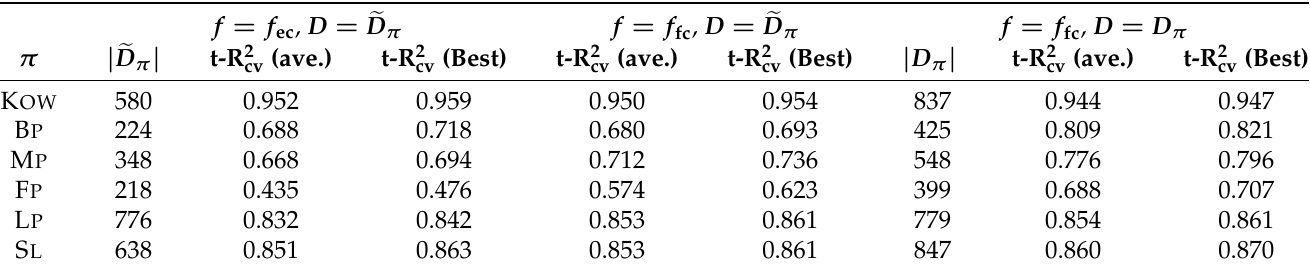
Table 5. Results of prediction functions by f ec and f fc in data set (cid:101) D π of cyclic graphs and f fc in data set D π of all graphs. f = f ec , D = (cid:101) D